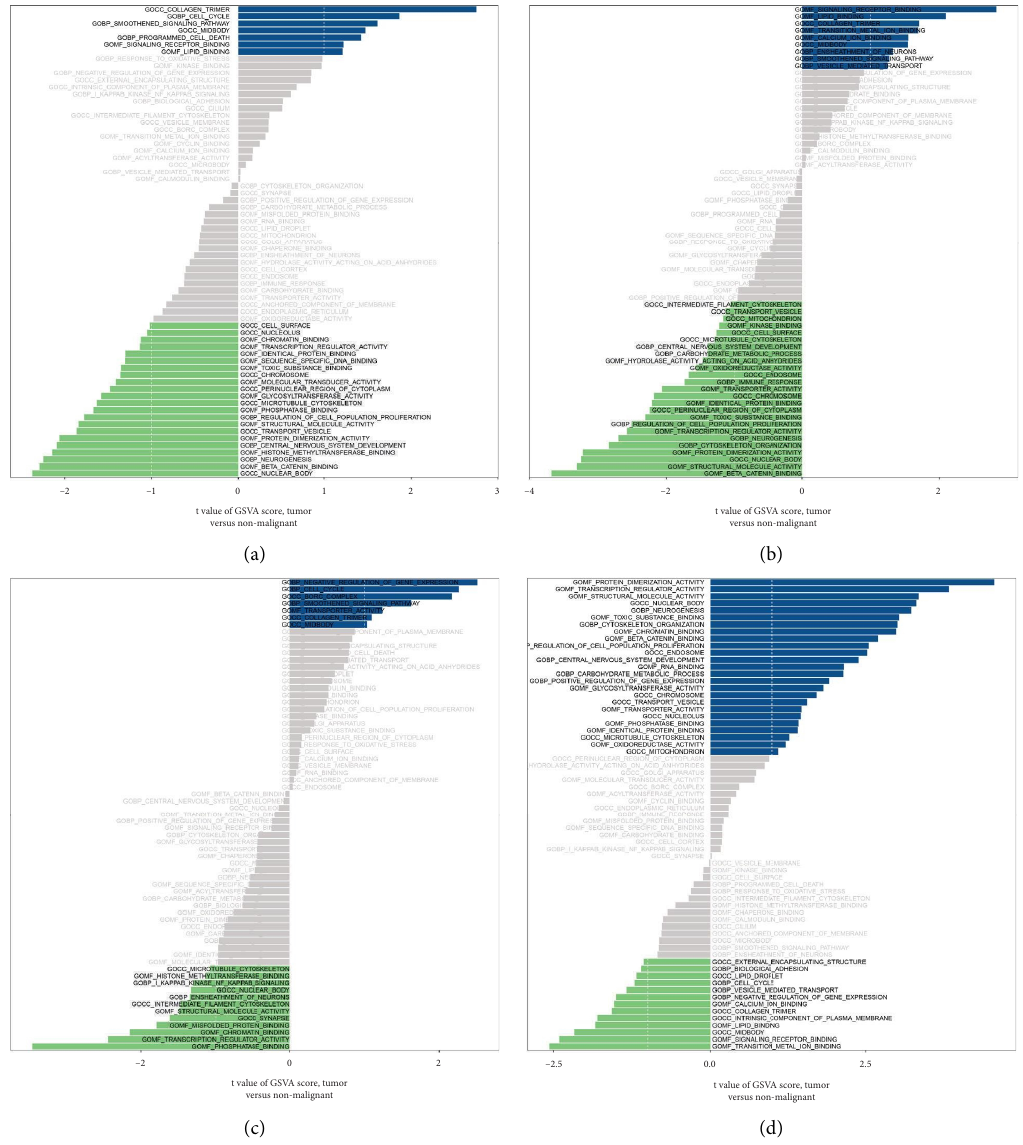
Figure 6: (a) GSVA of IRF8. (b) GSVA of MMP9. (c) GSVA of SPI1. (d) GSVA of